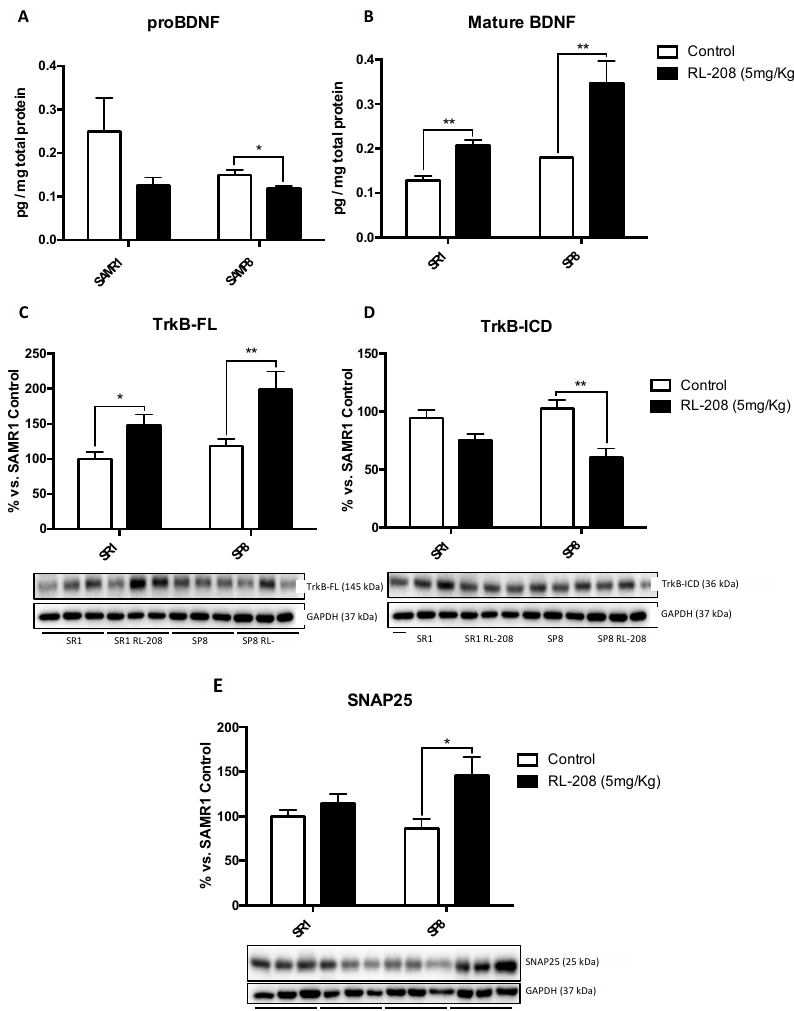
Figure 4. Protein levels of proBDNF ( A ), and mBDNF ( B ). Representative Western Blot and quantifications for TrkB-FL ( C ), TrkB-ICD ( D ) and SNAP25 ( E ). Values represented are mean ± Standard error of the mean (SEM); (n = 6 for each group). * p < 0.05; ** p < 0.01; *** p <